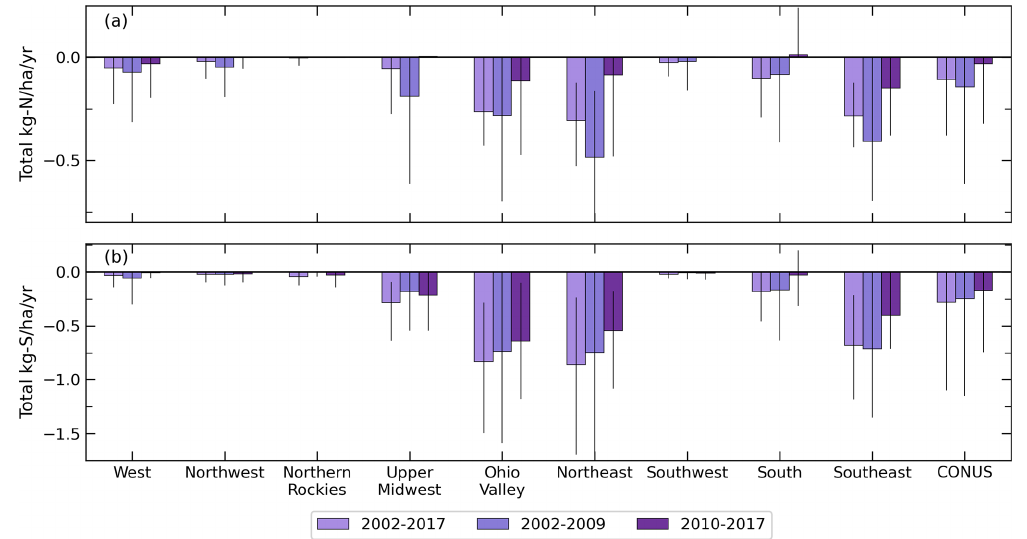
Figure 6. Comparison of mean total N (a) and total S (b) deposition trends in the nine CONUS climate regions from 2002–2017, 2002–2009, and 2010–2017. Lines on the bars extend to the 5th and 95th percentiles of the trends. Trends include all grid cell locations (insignificant trends are set to